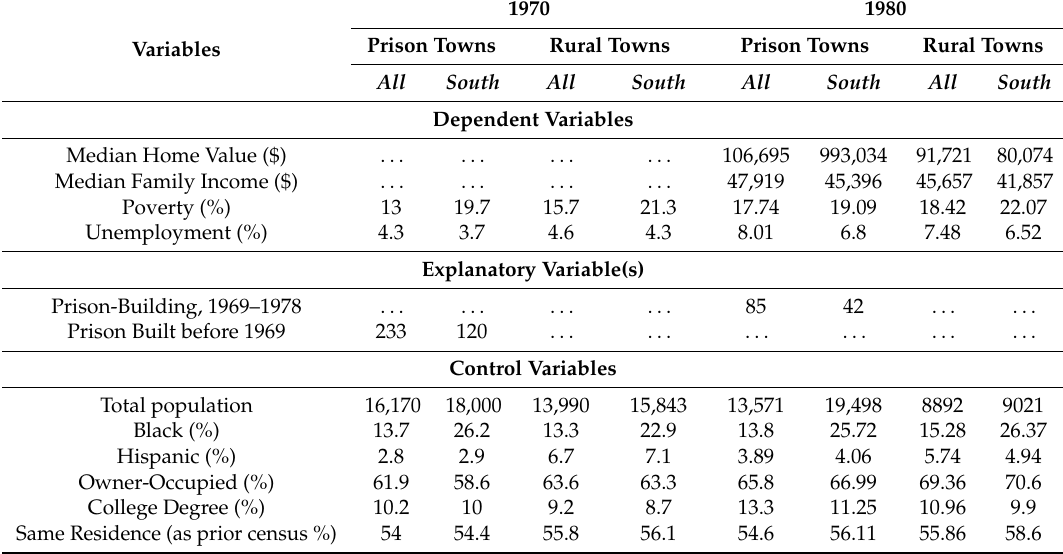
Table 2. Descriptive statistics of all variables included in the analysis from 1970 to 1980.